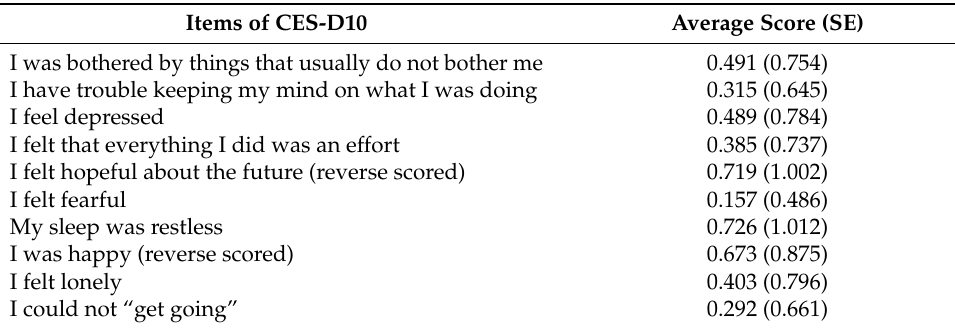
Table 2. Average score of respondents’ depression in each item of CES-D10. Items of